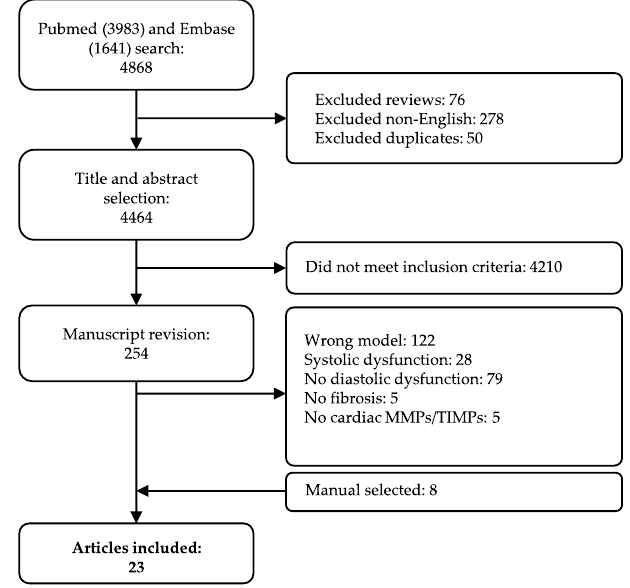
Figure 1. Flow chart of study selection. All articles are included and excluded according to the selection criteria defined in the Materials and Method section.